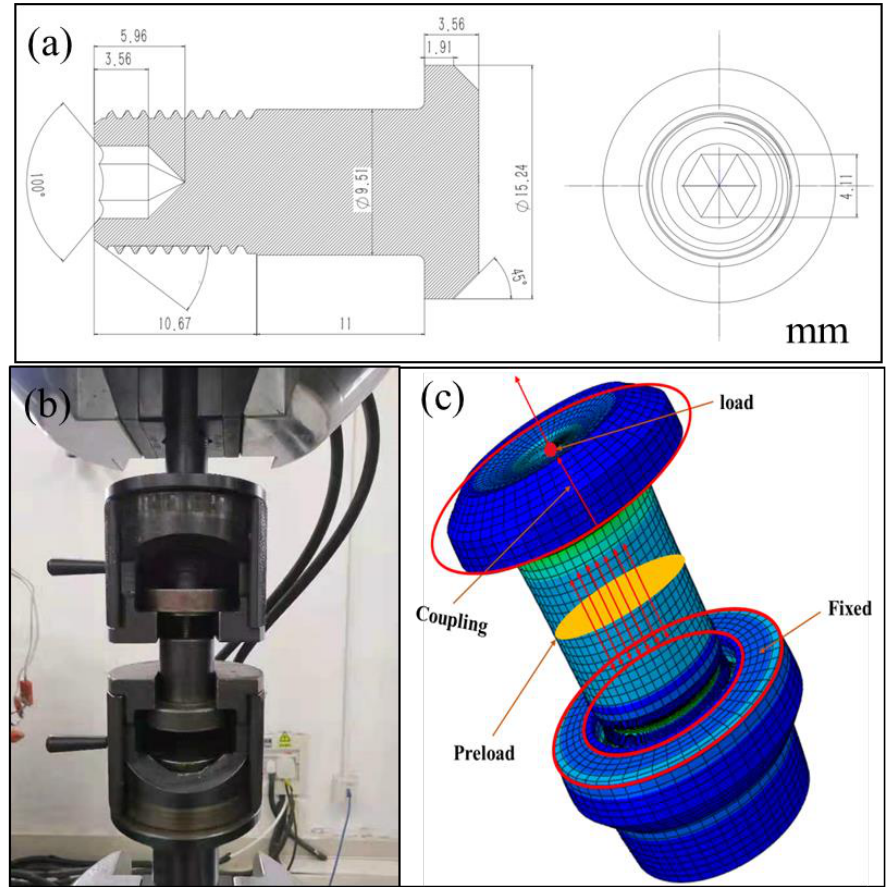
Figure 1. ( a ) Drawing of the bolt; ( b ) the test machine; ( c ) the basic FE